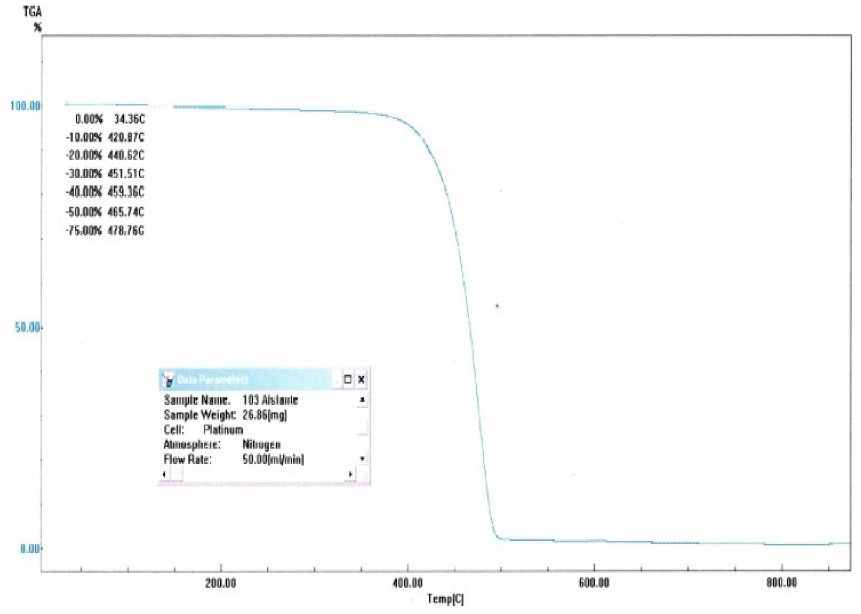
Figure 12. Results of the